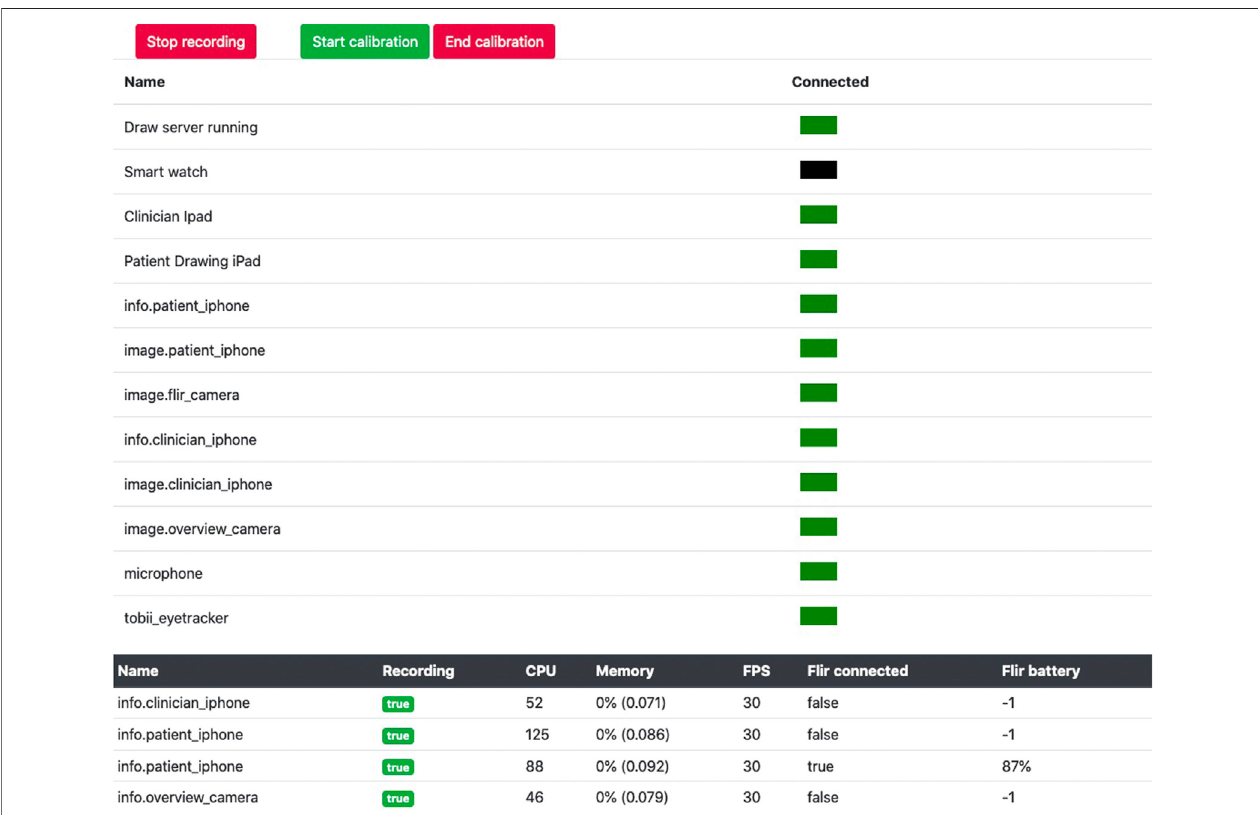
FIGURE4| Theclinicianinterface(inSwedish).ThepatienthasjustperformedtheTMTtest,anddrawntheconnectinglines.Theclinicianhasthenmadethescreen blank. The interface is designed to be operated through a touch